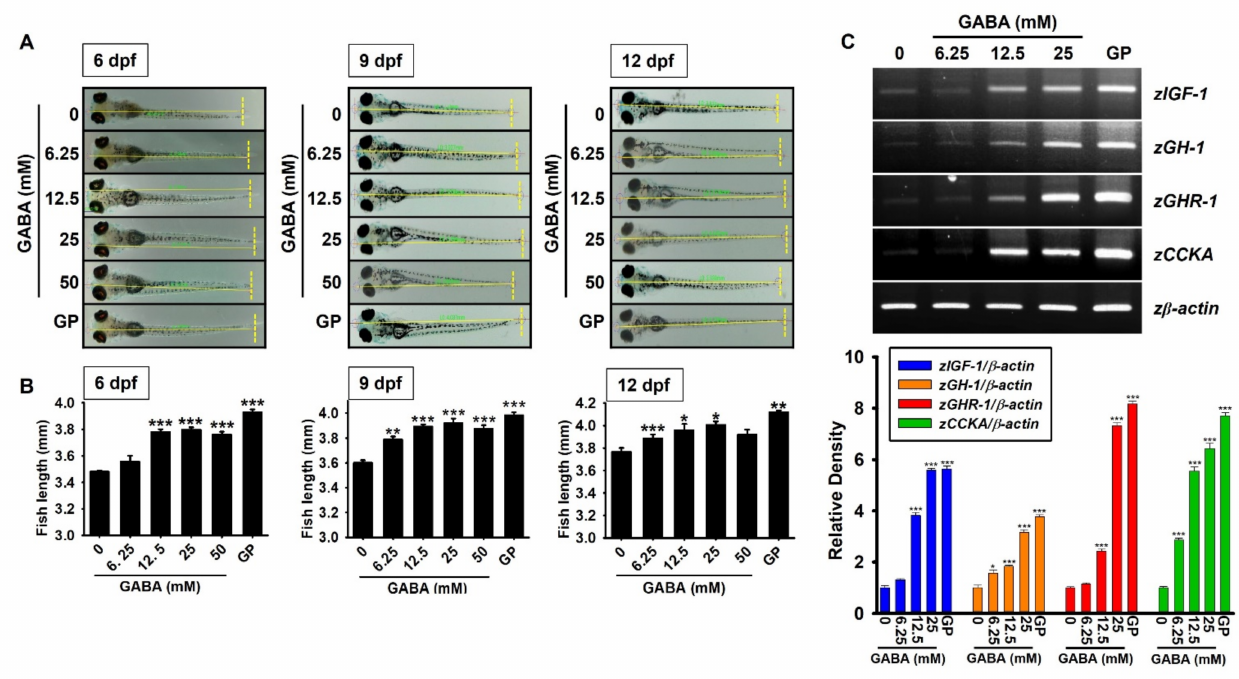
Figure 1. GABA promotes growth rate in zebrafish larvae through upregulation of growth-stimulating gene expression. Zebrafish larvae ( n = 20) at three days post-fertilization (dpf) were treated with the indicated concentrations of GABA (0–50 mM). ( A ) Total body length was measured at 6, 9, and 12 dpf using a stereomicroscope ( × 4). β -Glycerophosphate (GP) at 4 mM was used as a positive control. ( B ) Graphs represent the total body length corresponding to each dpf. ( C ) Total mRNA was extracted at 9 dpf, and reverse transcription-polymerase chain reaction was performed to measure the expression of insulin-like growth factor 1 ( zIGF-1 ), growth hormone 1 ( zGH-1 ), growth hormone receptor 1 ( zGHR-1 ), and cholecystokinin A ( zCCKA ) genes. z β -Actin was used as an internal control. Densitometry analysis was conducted to determine the expression level of each gene and expressed relative to that of β -actin ( bottom ). Significant differences among the groups were determined using one-way ANOVA followed by Bonferroni correction. All data are presented as mean ± standard error of the mean (* p < 0.05, ** p < 0.01, and *** p < 0.001 vs. untreated zebrafish